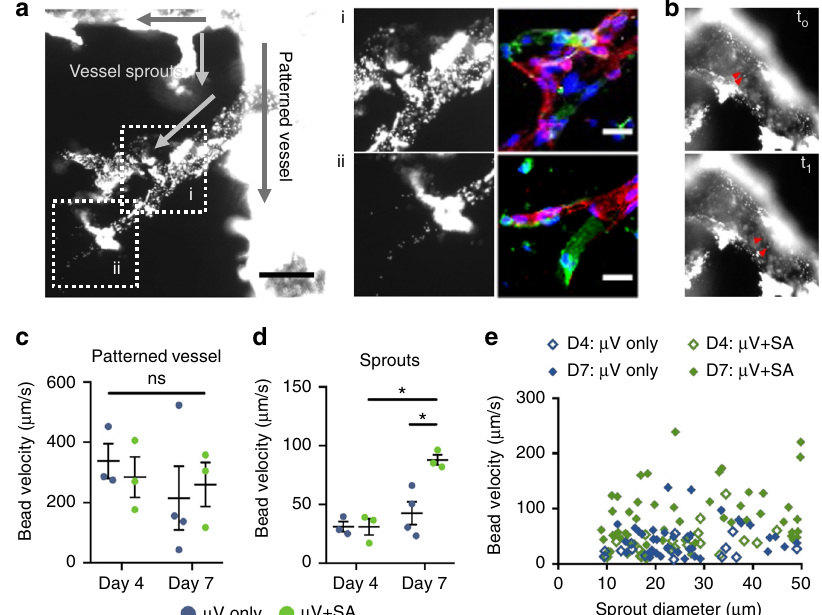
Fig. 2 Fluorescent bead perfusion of engineered microvessels ( µ Vs). a µ V + SA construct with perfused anastomotic connections. High magni fi cation views of outlined regions i and ii with corresponding in situ staining for mTm-hESC-ECs (DsRed + , red) and GFP-hESC-ECs (GFP + , green). Scale bars, 100 μ m, 40 μ m. b High magni fi cation view of fl uorescent beads at two time points, t 0 and t 1 , 0.27 s apart. Red arrows track the movement of fl uorescent beads to calculate velocities. c , d Average bead velocity in the patterned vessel ( c ) and in sprouts with diameter <50 µ m ( d ) in µ V only (blue circles) and µ V + SA (green circles) constructs after 4 days and 7 days of culture N = 3, 3, 4, and 3 biological independent samples for D4 µ V only, D4 µ V + SA, D7 µ V only, and D7 µ V + SA, respectively. p = 0.004 for D4 µ V + SA and D7 µ V + SA in sprouts, p = 0.012 for D7 µ V and D7 µ V + SA in sprouts, p > 0.05 for all others (two- tailed t test). e Scatter plot of bead velocity in relation to sprout diameter N = 15, 20, 37, 53 (number of sprouts analyzed) for D4 µ V only, D4 µ V + SA, D7 µ V only, and D7 µ V + SA in 2, 1, 5, and 3 biologically independent samples. Representative images for a , b from three biologically independent samples of D4 µ V + SA, with similar results. Hoechst-stained nuclei, blue. Error bars, mean ± SEM. * p < 0.05 determined using two-tailed t test. ns non-signi fi cant ( p > 0.05). D4 after 4 days of culture, D7 after 7 days of